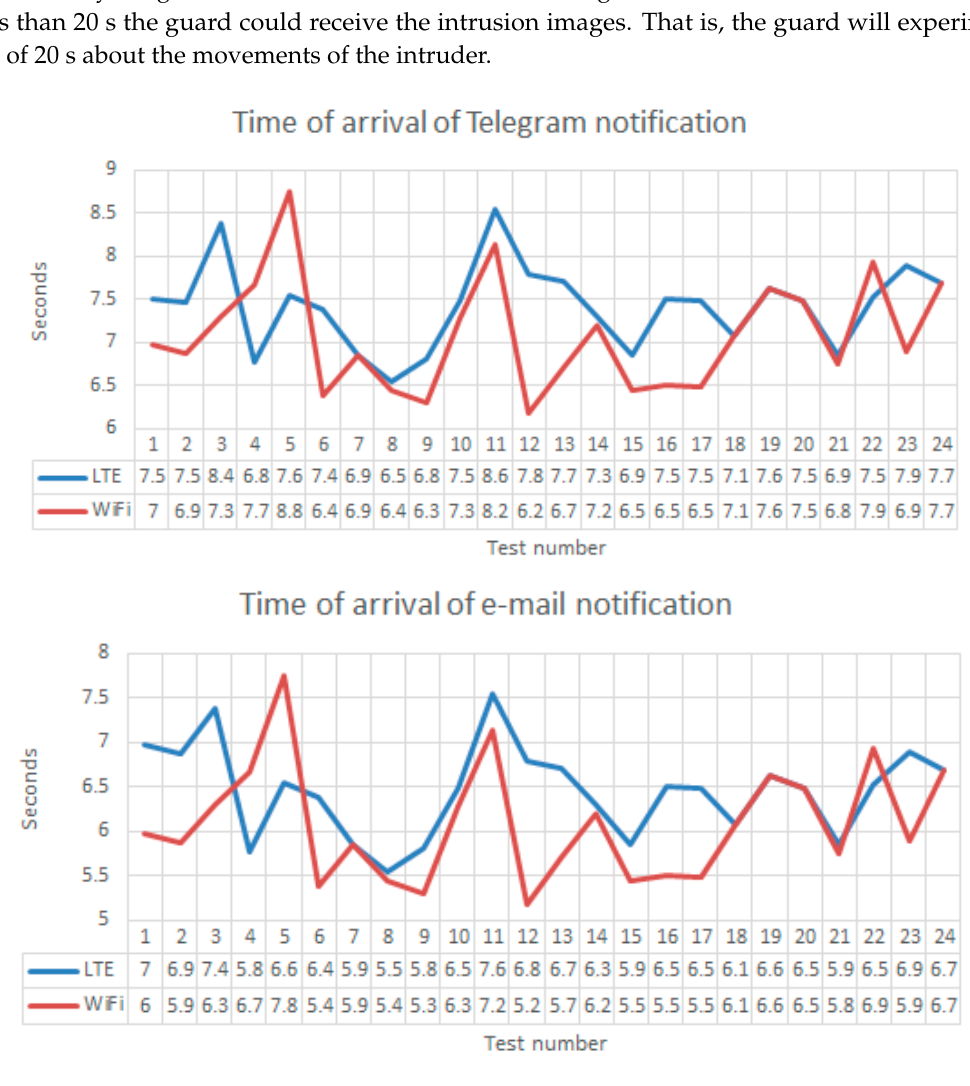
Figure 18. Time of arrival of notification messages of e-mail and Telegram using LTE and WiFi.